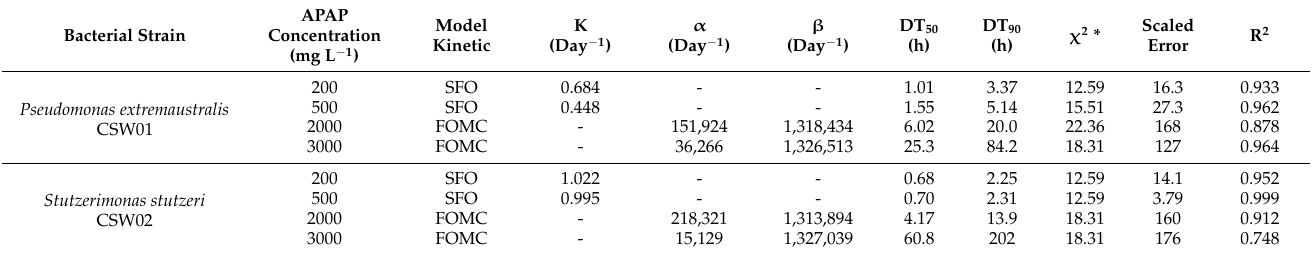
Table 4. Kinetic parameters calculated from the APAP biodegradation curves in solution after inoculation with P. extremaustralis CSW01 and S. stutzeri CSW02. Bacterial